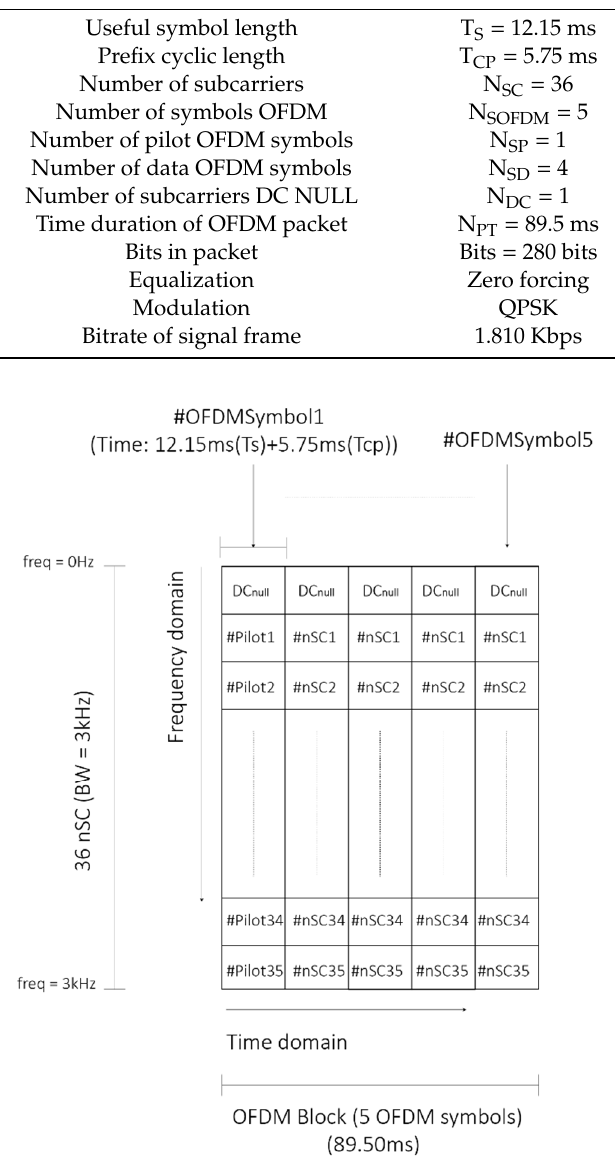
Figure 17. OFDM matrix configuration for NVIS with groundwave transmission.